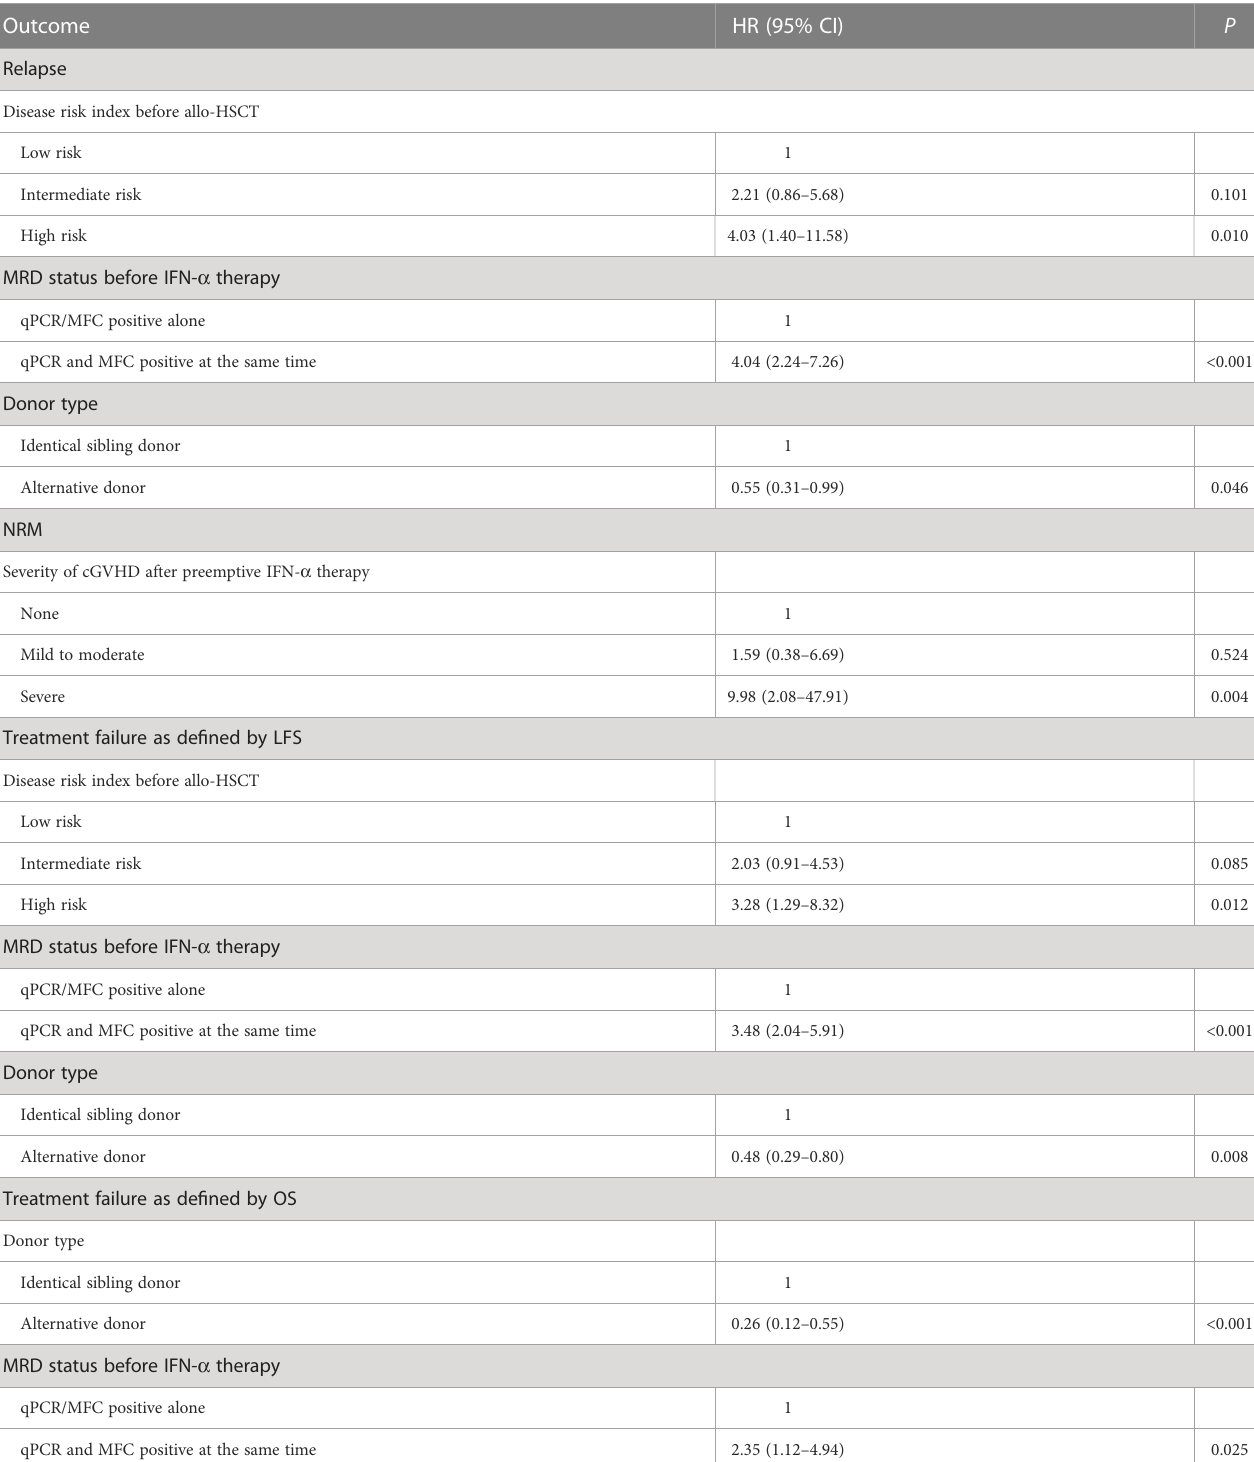
TABLE 2 Multivariate analysis of risk factors for 3-year clinical outcomes after preemptive IFN- a treatment. Outcome HR (95% CI) P